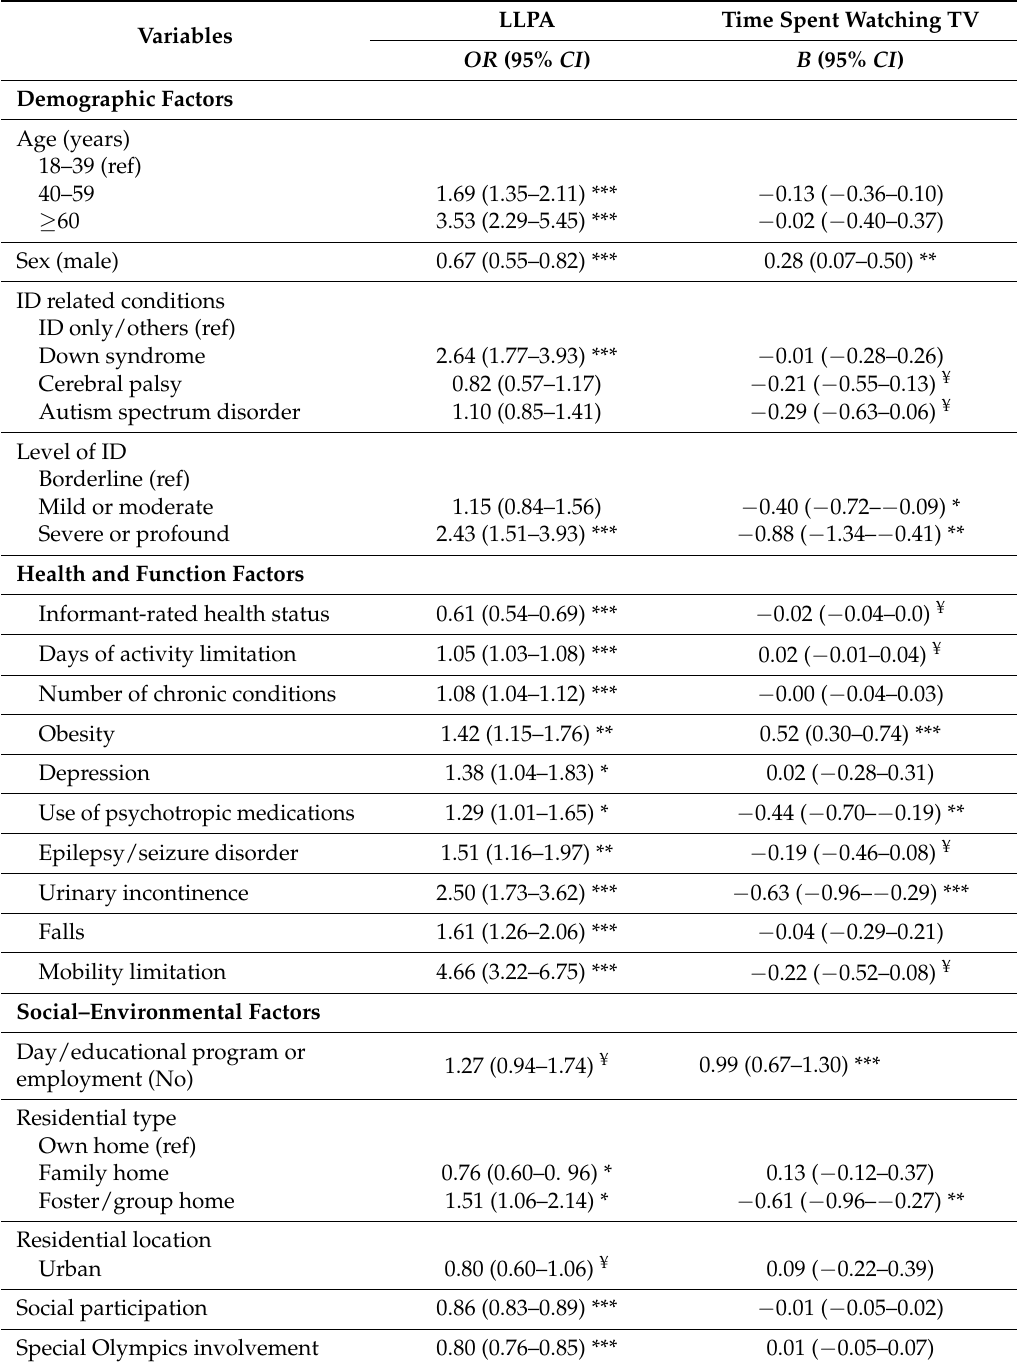
Table 2. Summary of univariate regressions for LLPA and time spent watching